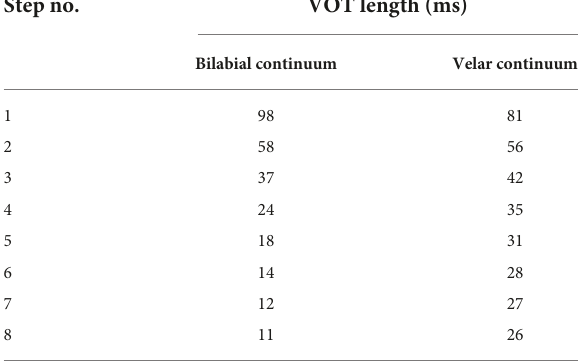
TABLE 2 VOT continua steps showing length of retained aspiration at each step (ms). Step no.